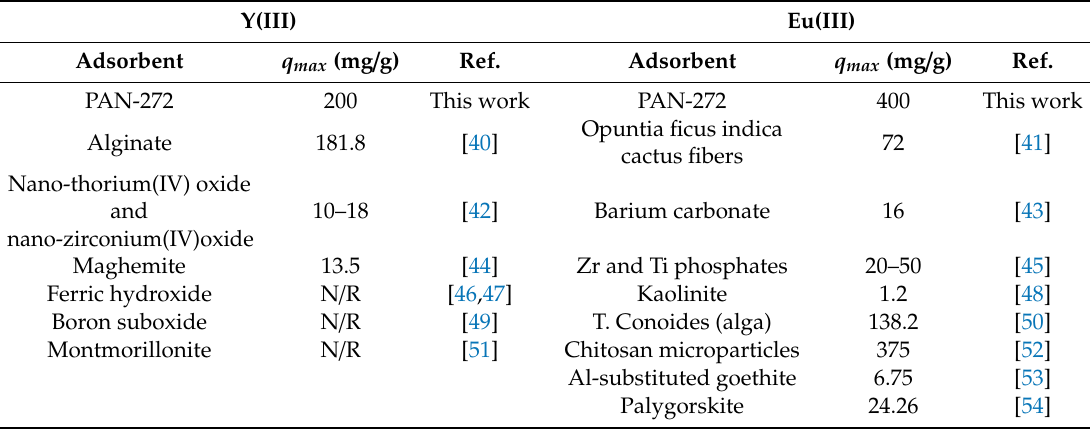
Table 1. Adsorption capacity comparison between di ff erent adsorbent